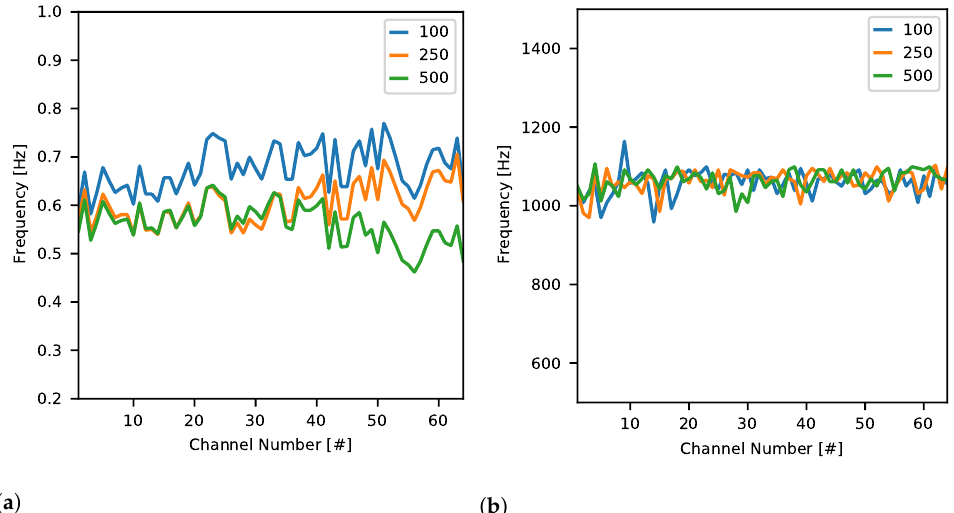
Figure 23. Minimum ( a ) high-pass ( b ) low-pass filter cut-off frequency obtained for the lowest possible band-pass filter settings and three different